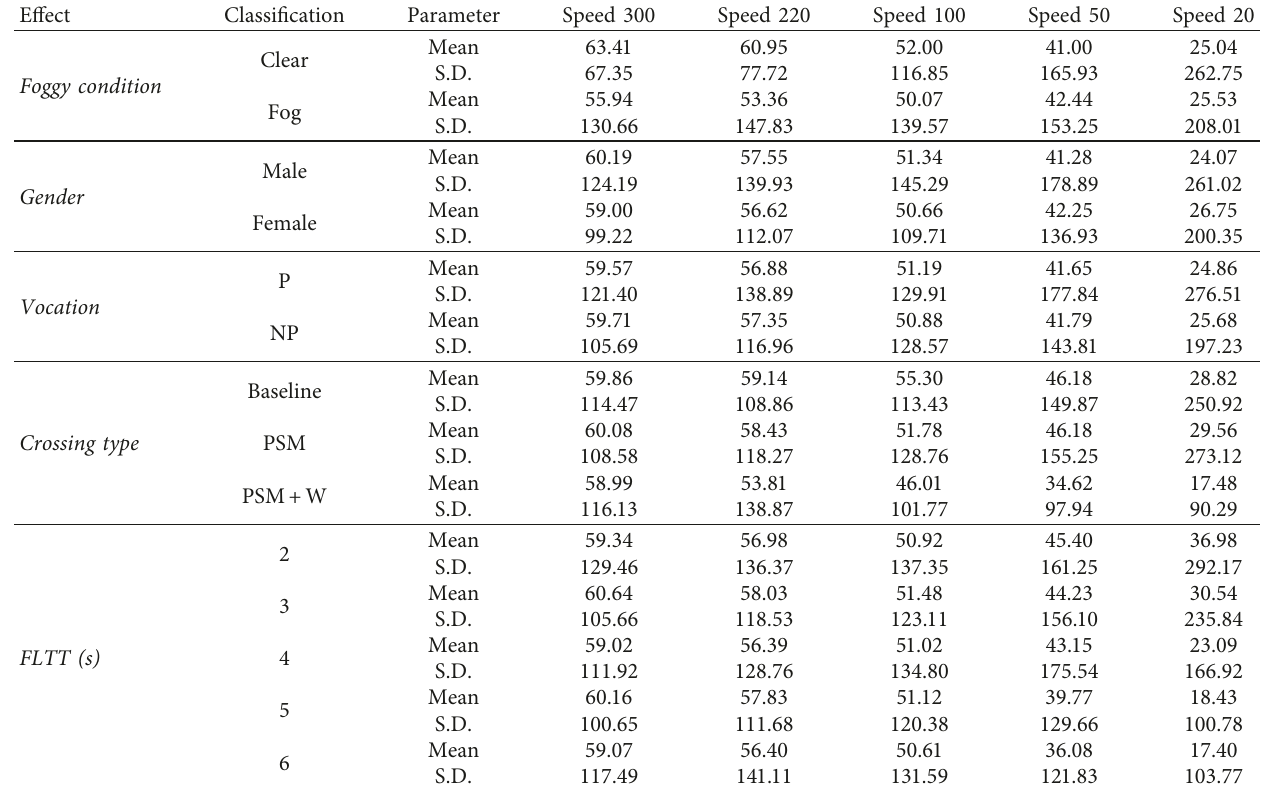
Table 2: Mean speed within different categories of factors.